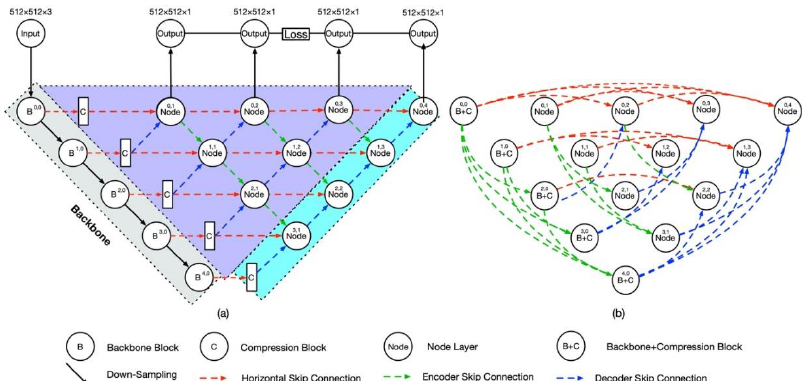
Figure 1. Architecture of the proposed Web-Nets. ( a ) shows the structure of Web-Net with adjacent connections. The five blocks in the grey areas represent the encoder backbone. The compression blocks are linked behind each level of encoder blocks to reduce the dimensions, and the solid arrow shows the normal downsampling (Max Pooling) operation. The light blue area is the decoder part of Web-Net, and the outputs of every node layers in the decoder are only fed into the node layers of upper levels in the vertical direction. The purple triangular area located at the corner of the Web-Net architecture is the node layers, which work as both encoders and decoders. The node layers obtain the features from their neighbouring layers, and then we simultaneously fuse the features and feed them into the adjacent node layers. The green, blue and red dotted lines indicate the feature transfers in the top-bottom, bottom-top and horizontal directions, respectively. ( b ) details the skip connections in Web-Net. The red dotted line represents the horizontal skip connections among the same levels, the green dotted lines denote the hierarchical top-bottom skip connections, and the blue dotted lines show the hierarchical bottom-top jump connections. Apparently, each regular triangle with di ff erent coloured edges constructs a mini encoder-decoder